Question: What form of chart is displayed?
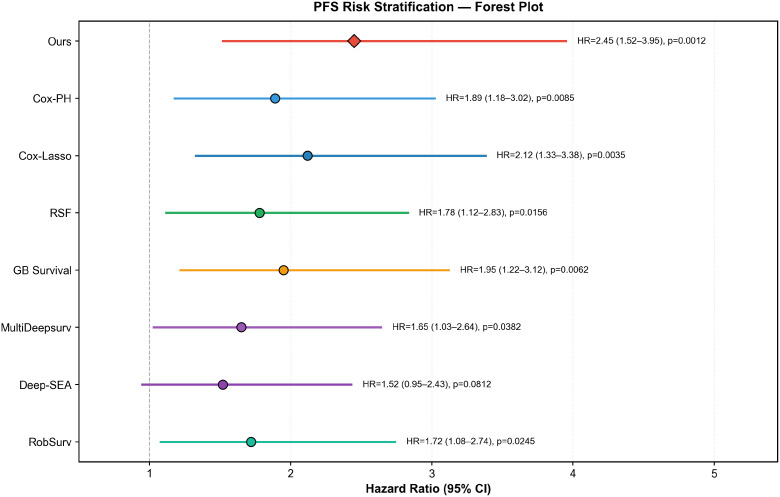
Answer: forest